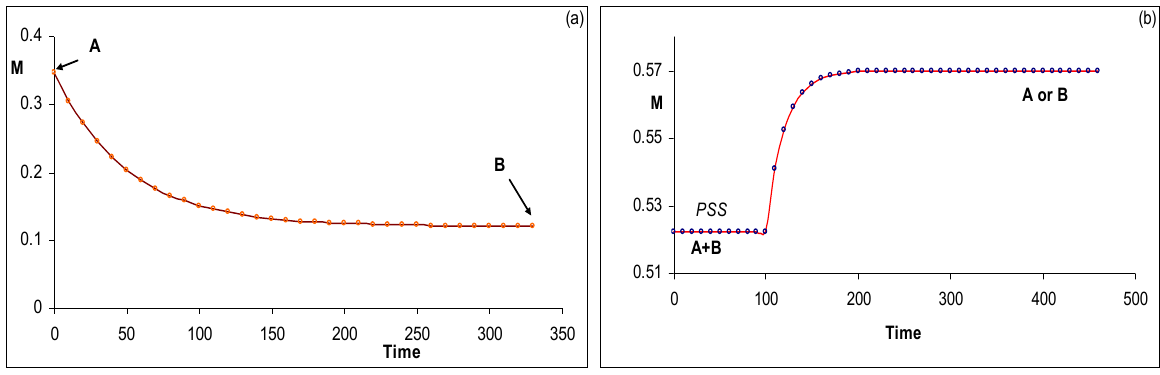
Figure 6. Examples of unimolecular thermal reaction